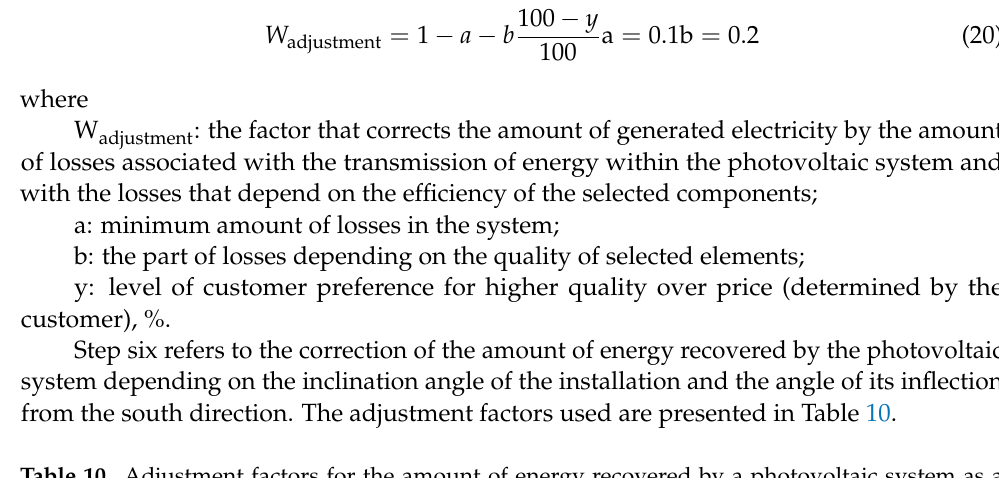
Table 10. Adjustment factors for the amount of energy recovered by a photovoltaic system as a function of the inclination angle of the installation and the angle of its inflection from the south. The color marks the height of the correction factor from “green” the smallest to “red” the greatest. Angle of Inflection from the